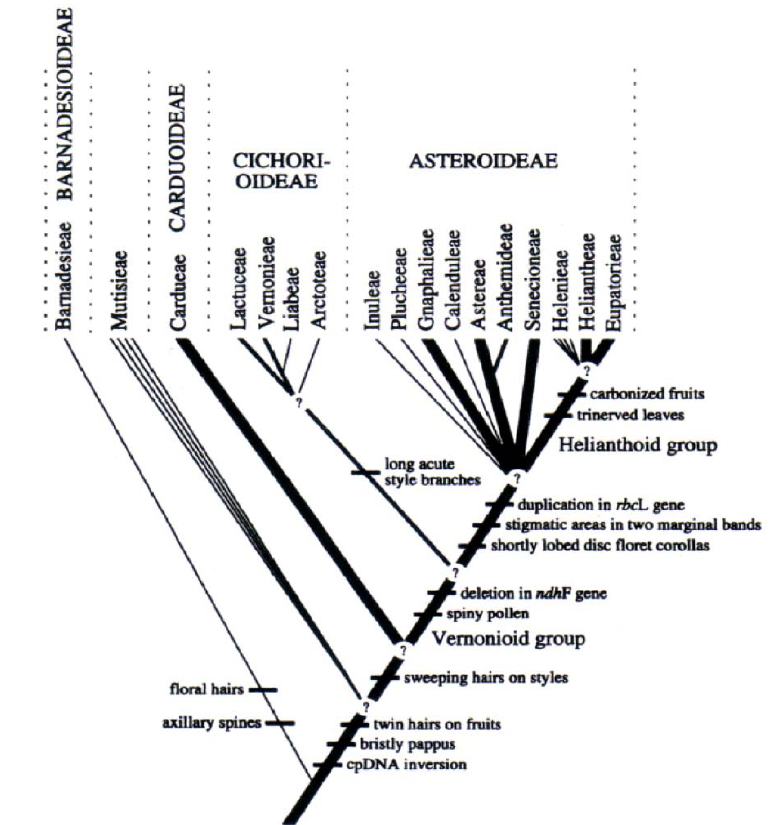
Figure 1. Phylogenetic diagram of the Asteraceae tribes, according to Bremer